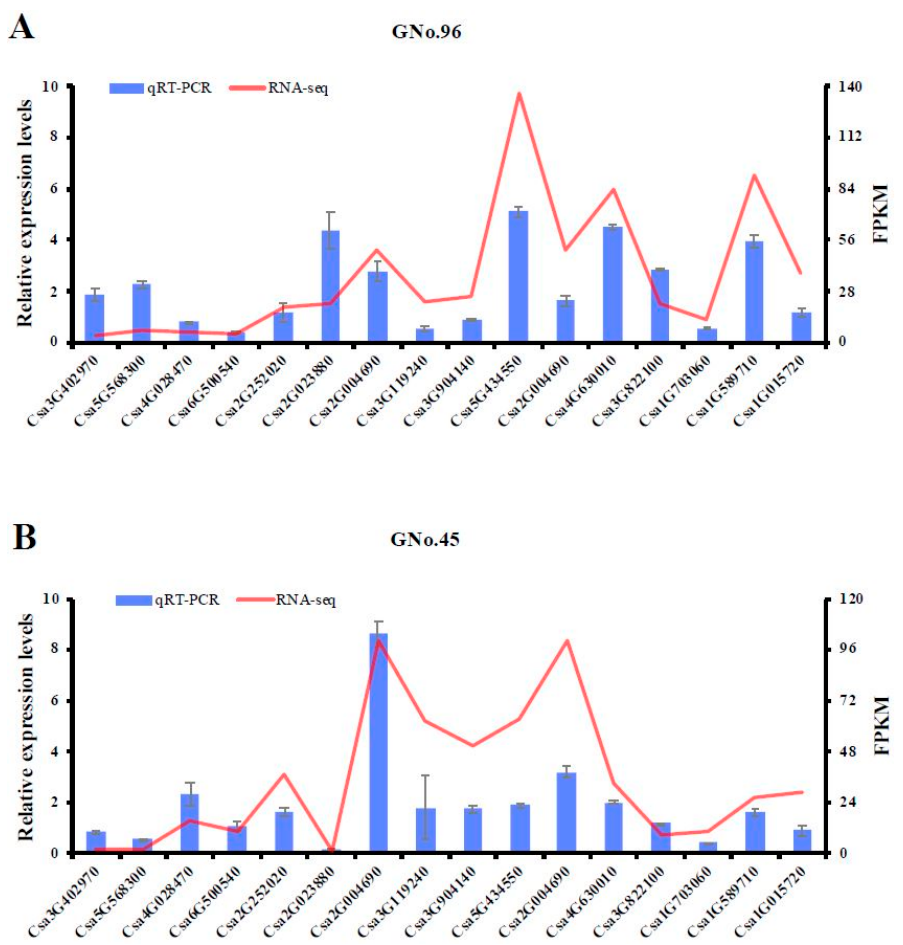
Figure 8 . Relative expression levels of 16 genes in cucumber fruits from ( A ) GNo.45 and ( B ) GNo.96, as determined by qRT-PCR and fragments per kilobase of transcript per million (FPKM) mapped reads methods.